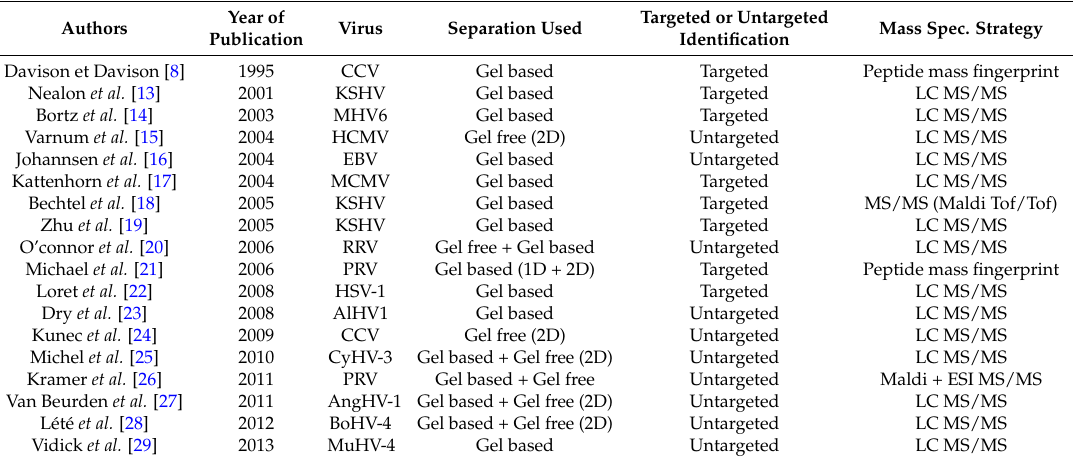
Table 1. Strategies used in the analyses of the structural proteome of